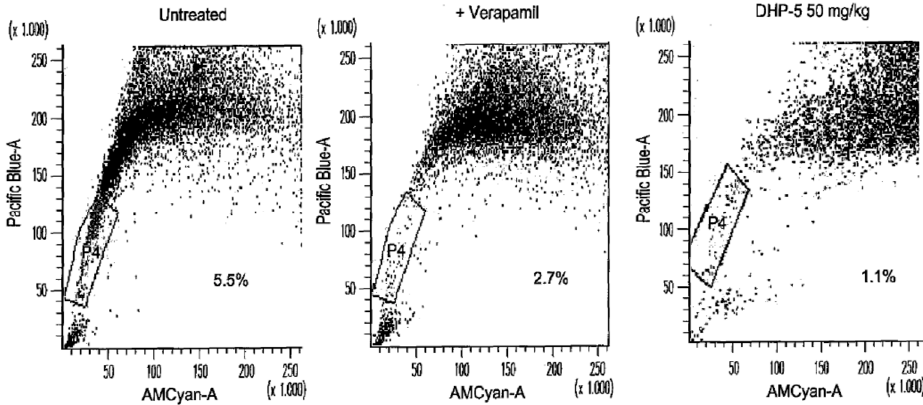
Figure 5. Scatter plot showing results of side population analyses of tumor-derived cells of the LOVO xenograft that were untreated, treated with side population inhibitor reference drug Verapamil (200 µ M) and with DHP-5 (50 µ M).